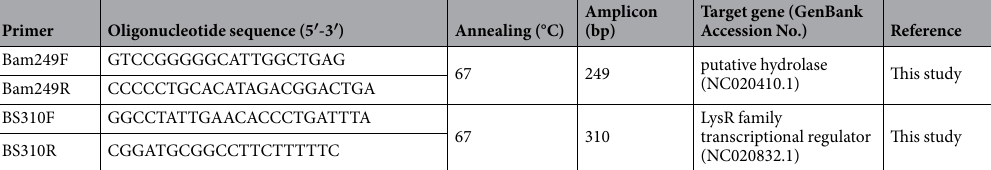
Table 1. Primer sequences, their targets, and the annealing temperatures used in Bacillus velezensis and B. subtilis subsp . subtilis PCR